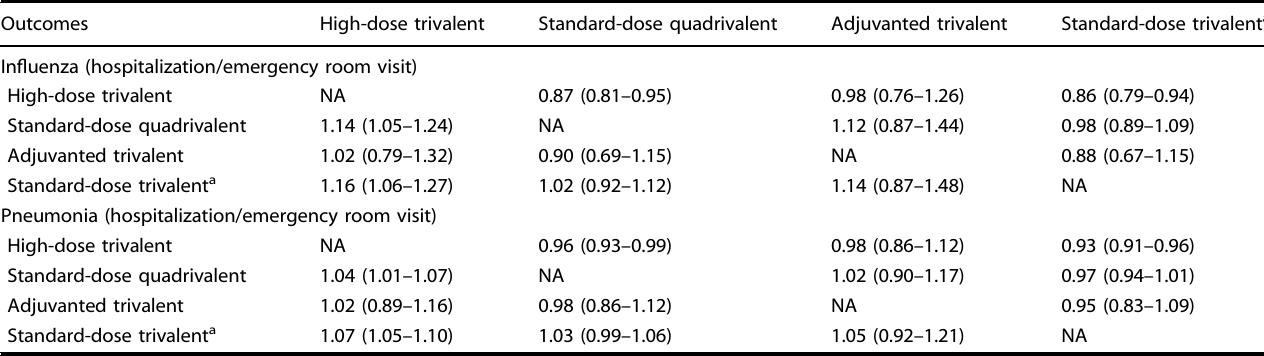
Table 2. Adjusted hazard ratios and 95% con fi dence intervals for outcomes in pairwise comparisons (reference groups are indicated in the columns) in pooled analyses across all seasons (2012/2013 – 2017/2018).